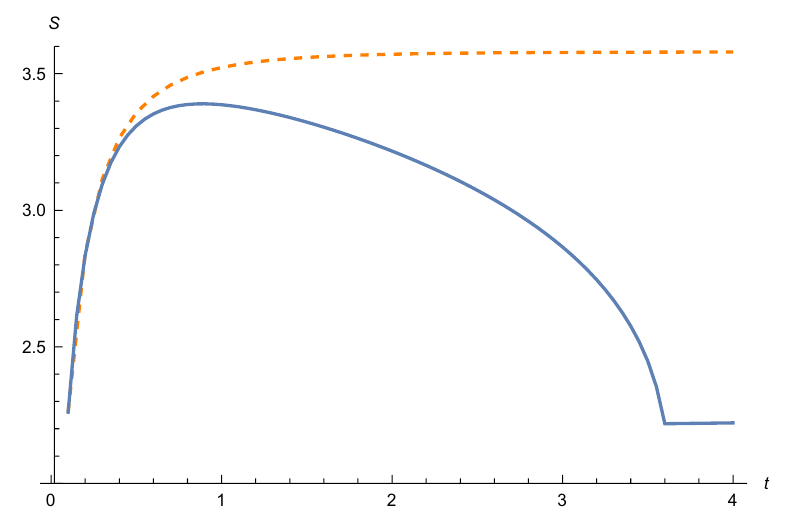
Figure 3 . Plot of the von Neumann entropy S in (2.43) as a function of t = g s K . We set ξ = 18 , β = 4 , g s = 1 / 100 in this figure. The solid blue curve is the dynamical brane case while the dashed orange curve is the probe brane